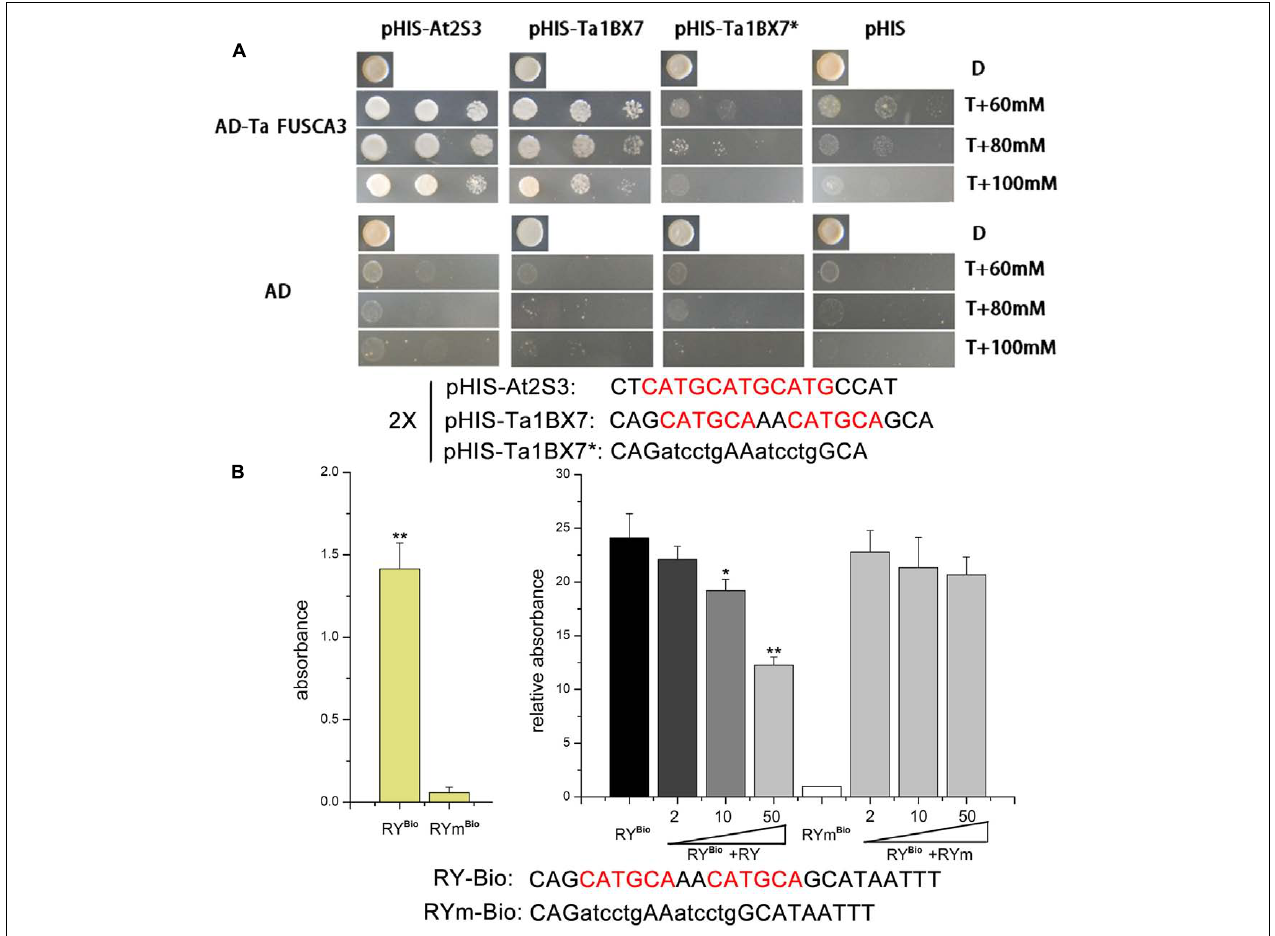
FIGURE 6 | TaFUSCA3 interacts with the RY-box from the promoter of Ta1Bx7 . (A) Analysis of the RY-box binding activity of TaFUSCA3 by use of the yeast one-hybrid (Y1H) assay. The effector vectors were pGAD-TaFUSCA3 and pGADT7 and reporter vectors were pHIS-At2S3, pHIS-Ta1Bx7, pHIS-Ta1Bx7 ∗ , and pHIS, which was used for the Y1H system. The culture medium lacked Trp, Leu, and His with 3-amino-1,2,4-triazole (3-AT) added at a concentration of 60, 80, or 100 mM. (B) The specific binding property of the recombinant TF TaFUSCA3 to 5 (cid:48) -biotinylated dsDNA probes and competition experiment by DPI-ELISA. The RY-box probe from the promoter of Ta1Bx7 was biotinylated at 5 (cid:48) end. ELISA plates were coated with 2 pmol of double-stranded biotinylated RY Bio-probe. The specific binding of TaFUSCA3 to RY-probes was competed with non-biotinylated dsDNA in the competition experiment. Different concentrations of RY-probe or RYm-probe (0, 2, 10, 50 pmol) were added into the crude extract immediately before incubation. The biotinylated dsDNA RYmBio-probe incubated with the extract was regarded as a control. Data are means ± SD ( n = 3) in the specific binding and competition assays. Asterisks represent statistically significant differences from the RYm-probe (0 pmol) ( ∗ P < 0.05, ∗∗ P <